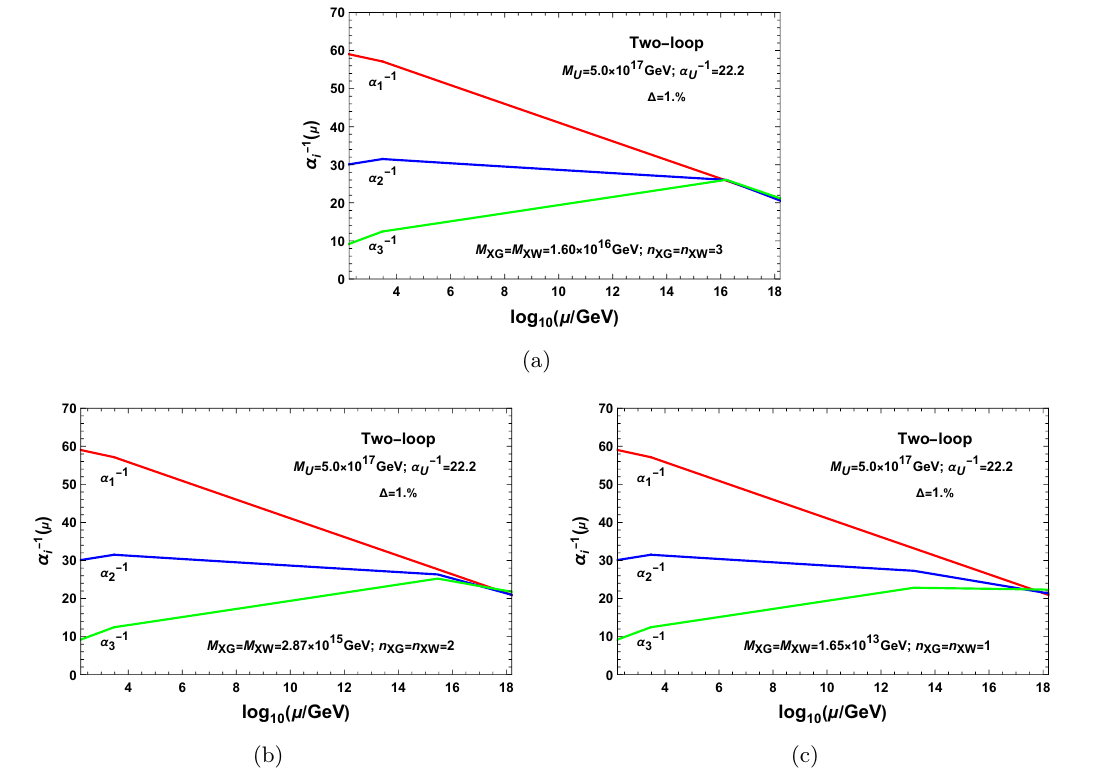
Figure 1 . Two-loop evolution of gauge couplings for the Model 1 with vector-like particles. In the model, k = 1 × 5 and k = 1 . The string-scale gauge coupling relations can be achieved by adding Y 2 3 3( XG + XW ) (a), 2( XG + XW ) (b) and ( XG + XW )